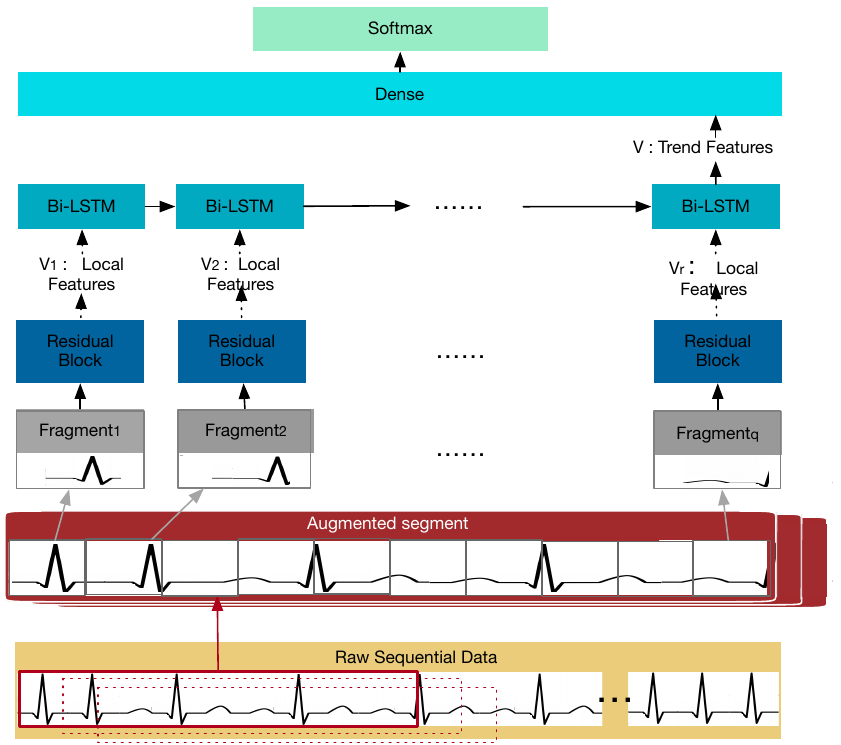
Figure 3. The high-level architecture of the multi-view RCR-Net